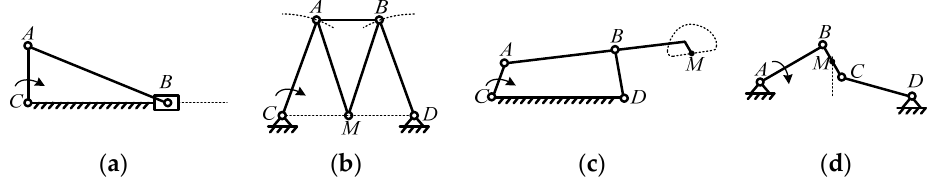
Figure 12. Linear track mechanisms. ( a ) Crank–slider mechanism ( A , B , C : Hinge; B : Key point.); ( b ) Robert mechanism ( A , B , C , D , M : Hinge; A , B , M : Key point.); ( c ) λ mechanism ( A , B , C , D : Hinge;